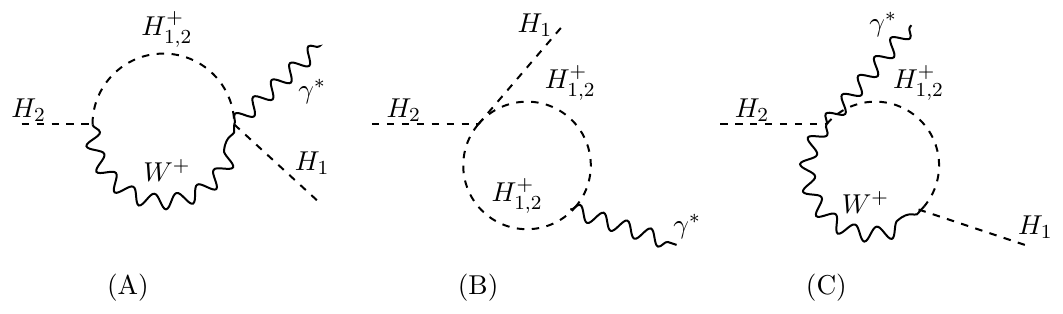
Figure 4 . Bubble diagrams contributing to the H 2 ! H 1 (cid:13) (cid:3) decay, where the lightest inert particle